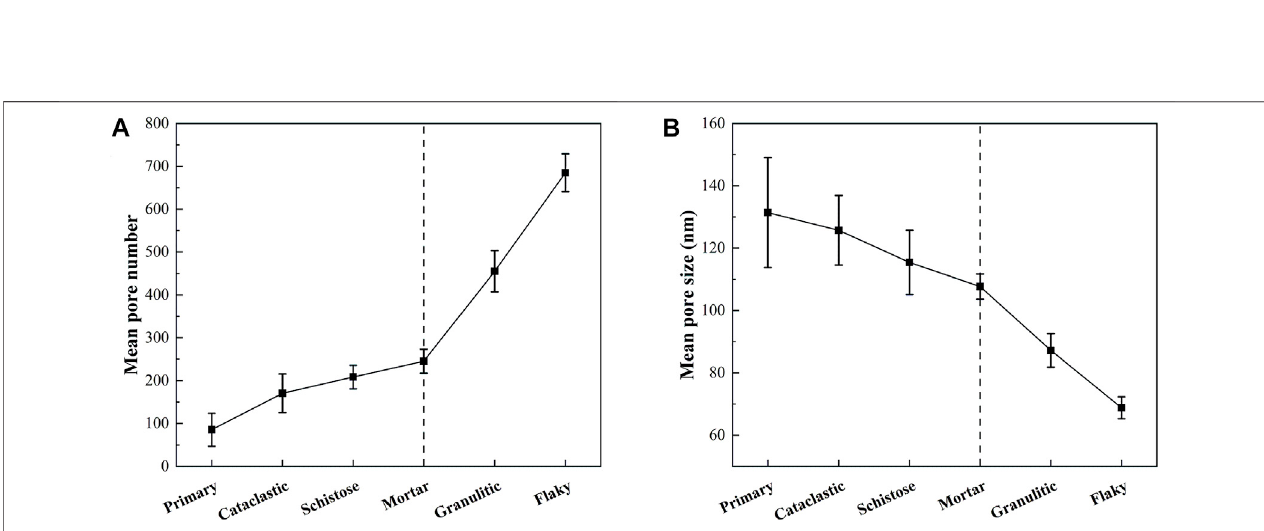
FIGURE 7 | Relationships between mean pore number, mean pore size and tectonic deformation degree. (A) Mean pore number of coal samples; (B) Mean pore size of coal samples.